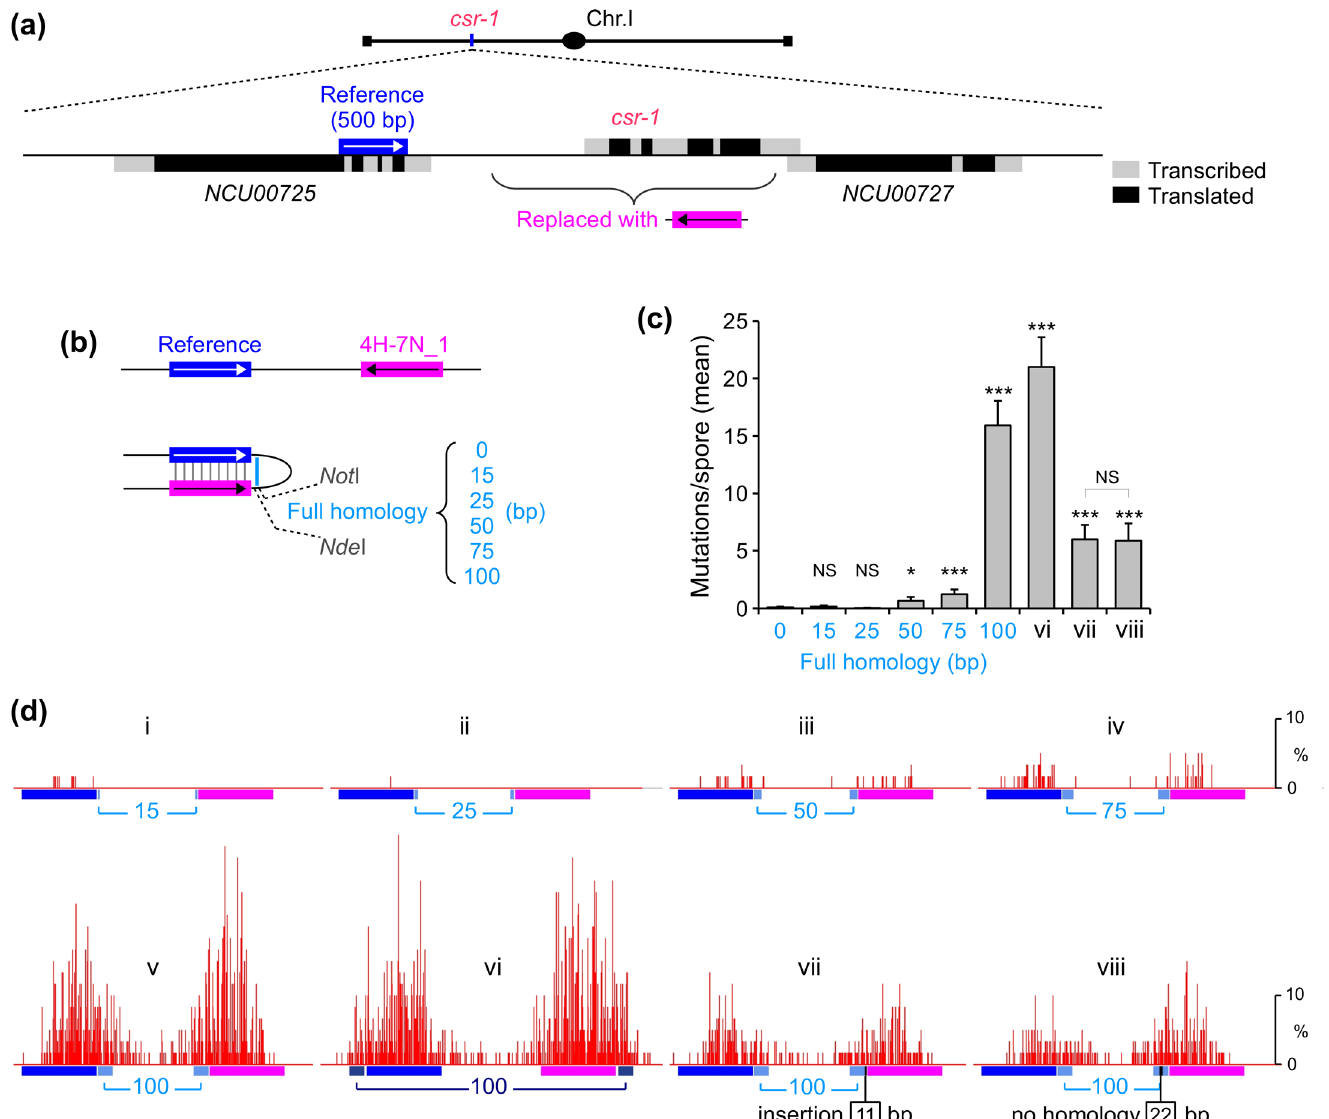
Fig 2. Short regions of perfect homology promote RIP mutation in combination with the 500-bp interspersed homology 4H-7N_1. (a) Partially- homologous repeats containing 500 base-pairs of the interspersed homology 4H-7N_1 (as defined in Fig 1A) are created by replacing the cyclosporin- resistant-1 gene ( csr-1 ) with synthetic DNA. (b) Derivatives of the basic repeat construct include 0 – 100 base-pairs of perfect homology created by integrating additional DNA between restriction sites Not I and Nde I. The repeat construct with 0 base-pairs of perfect homology was reported previously [14]. (c) The mean number of RIP mutations detected across the entire sequenced region for repeat constructs described in (Panels b and d). X-axis: Arabic numerals refer to the length of perfect homology inserted between Not I and Nde I sites, as shown in (Panel b); Roman numerals refer to additional repeat constructs tested in (Panel d). Error bars represent the standard error of the mean. The total number of sequenced spores and replica crosses are provided in S1 Table. (d) RIP mutation profiles for selected repeat constructs. Roman numerals correspond to the following RepeatIDs (provided in S1 Table): i —“ XIQ ” , ii —“ XIO ” , iii —“ XIN ” , iv —“ XJG ” , v —“ XIM ” , vi —“ XKE ” , vii —“ XJH ” , viii —“ XJY ” . The number of mutations per site is expressed as percent of all spores sequenced for a given repeat